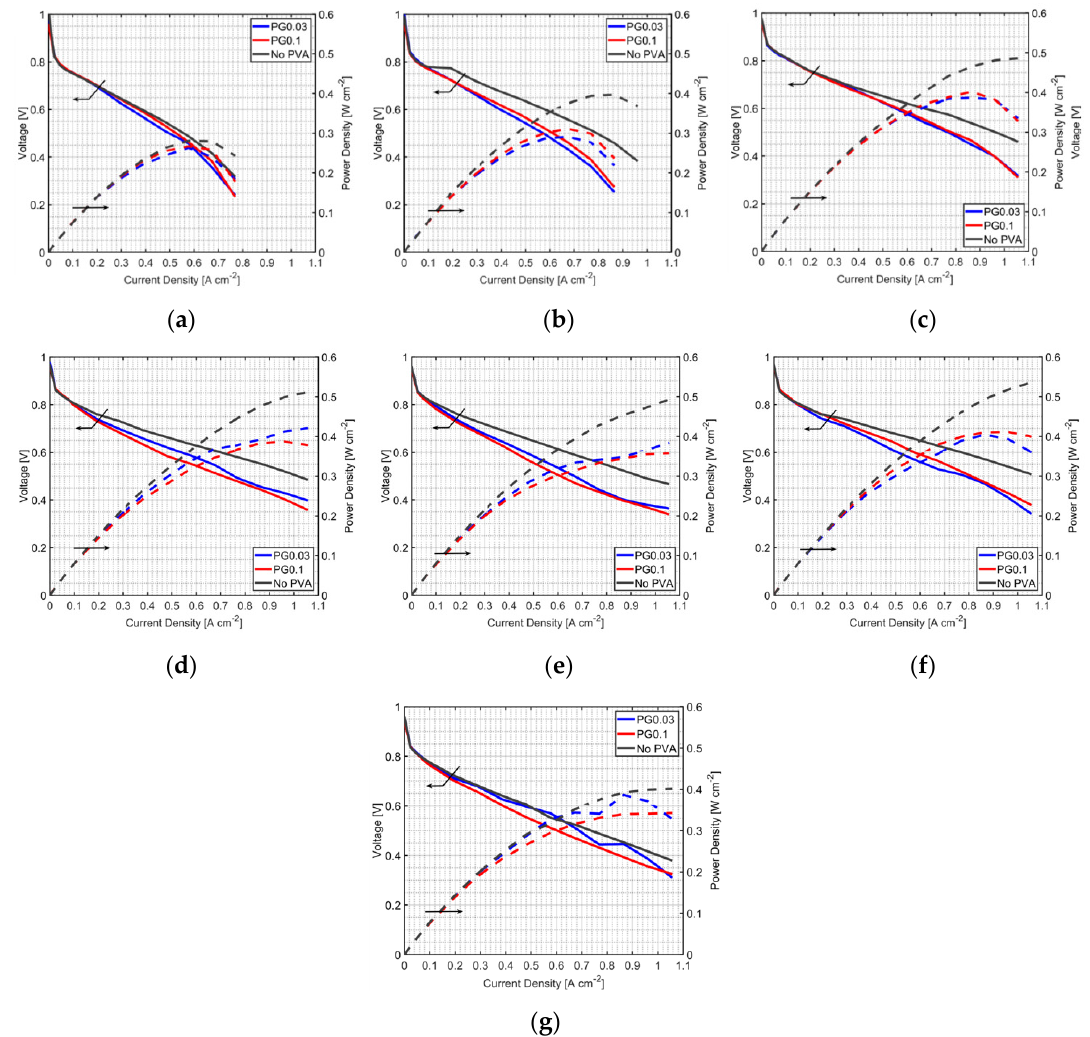
Figure 6. MEA with the PG method at a fuel cell temperature of 60 °C, and an anode and cathode humidifier temperature of ( a ) 25 °C, ( b ) 30 °C, ( c ) 40 °C, ( d ) 50 °C and ( e ) 60 °C; and a fuel cell temperature of 70 °C, and an anode and cathode humidifier temperature of ( f ) 60 °C and ( g ) 70 °C.